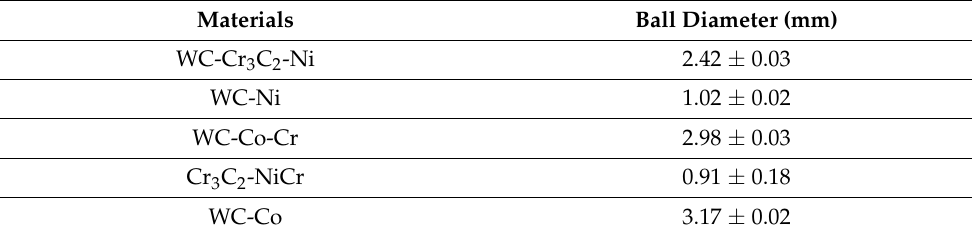
Figure 9. Three-dimensional image of the wear tracks of ( a ) WC-Cr 3 C 2 Ni-Cr; ( b ) WC-Ni; ( c ) WC-Co- Cr; ( d ) Cr 3 C 2 -NiCr and ( e ) WC-Co. Table 6. Ball diameter measurements at the end of the tribological